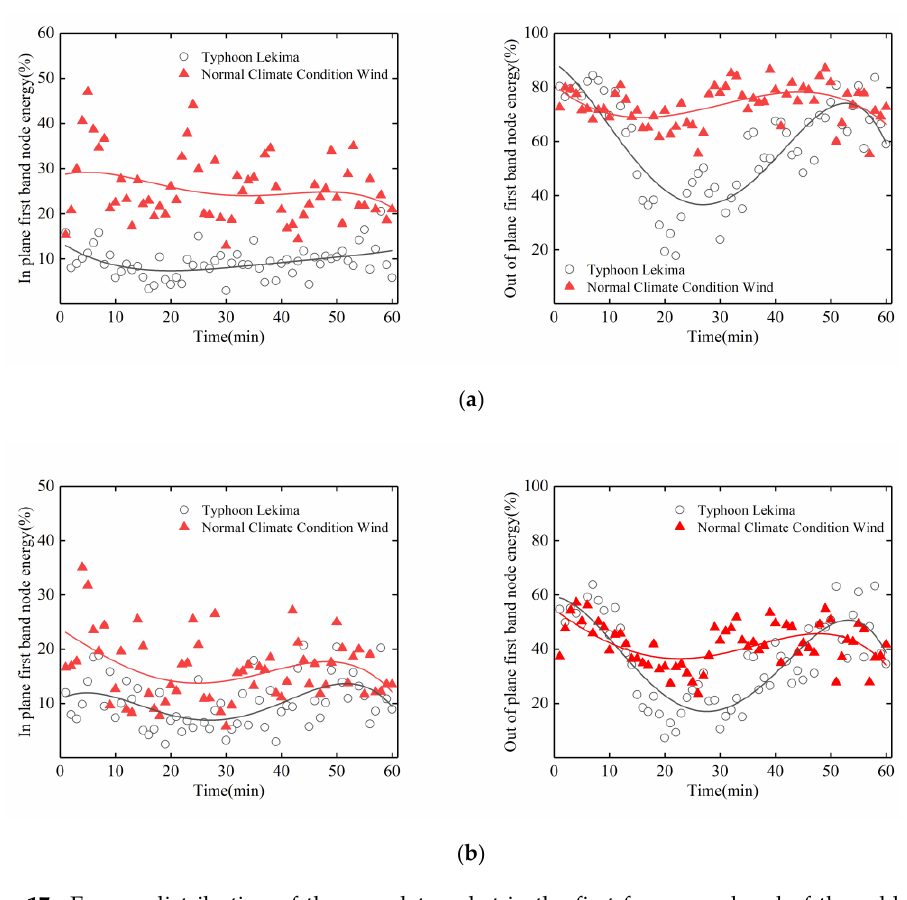
Figure 17. Energy distribution of the wavelet packet in the first frequency band of the cable: ( a ) Upstream; ( b ) Downstream.